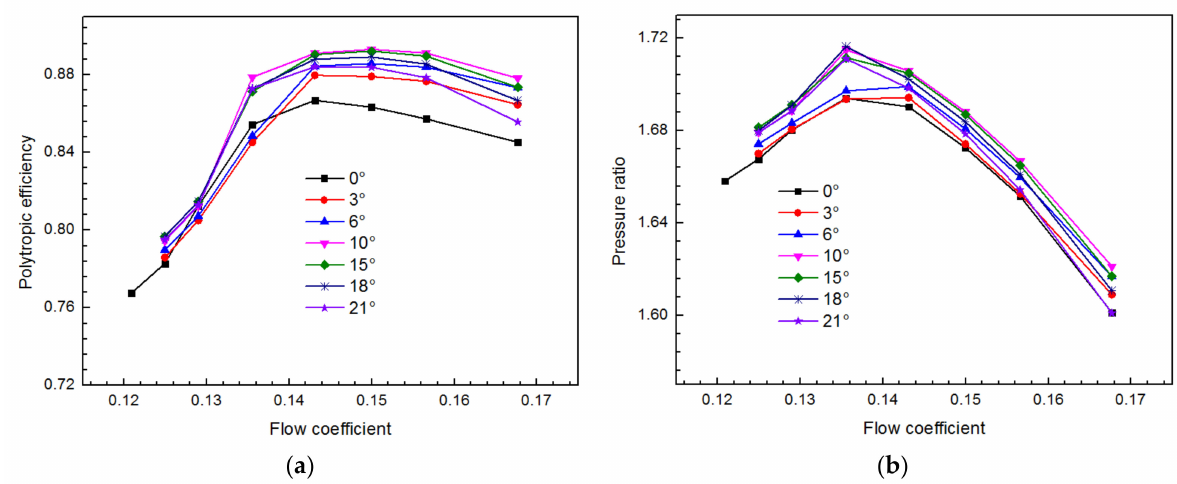
Figure 6. Centrifugal compressor stage performance with various total bending angle. The best performance is obtained by the 10 ◦ model of the tandem blade diffuser. ( a ) Polytropic efficiency and ( b ) Total Pressure